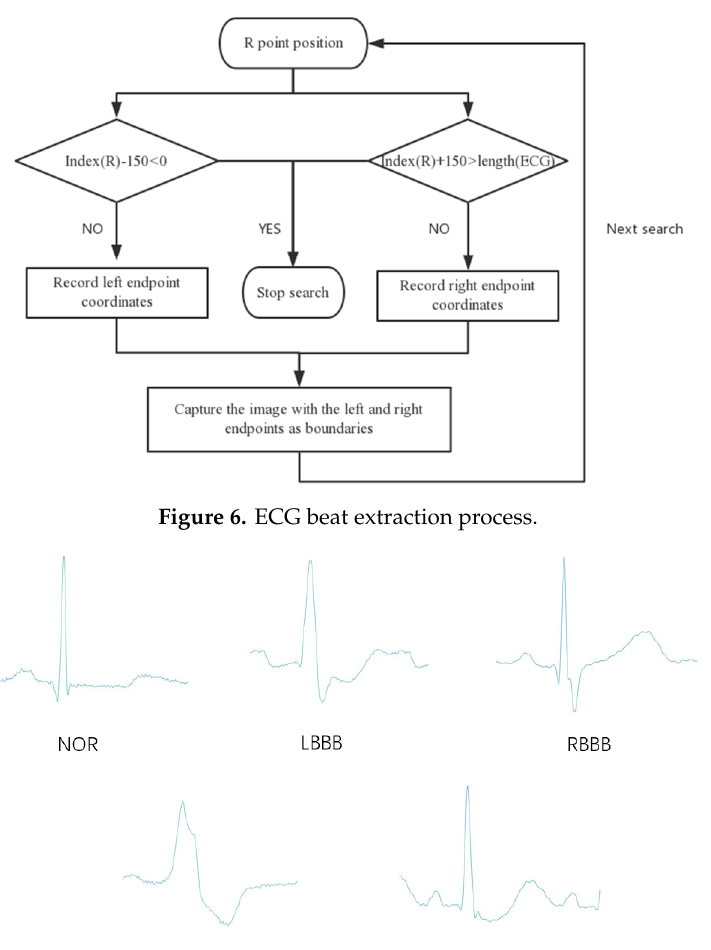
Figure 7. Normal beat and four ECG arrhythmia beats.